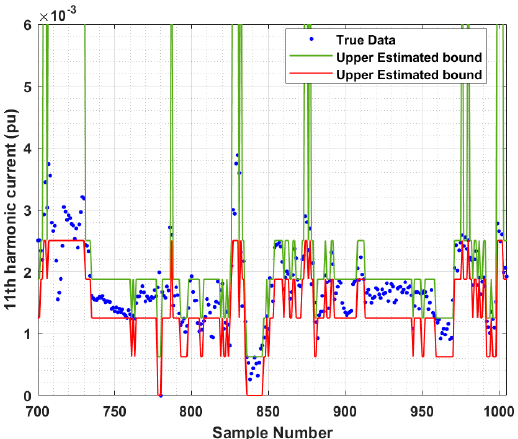
Figure 12. True value, upper estimated bound and lower estimated bound for 11th harmonic current of WF4 by using three meters.